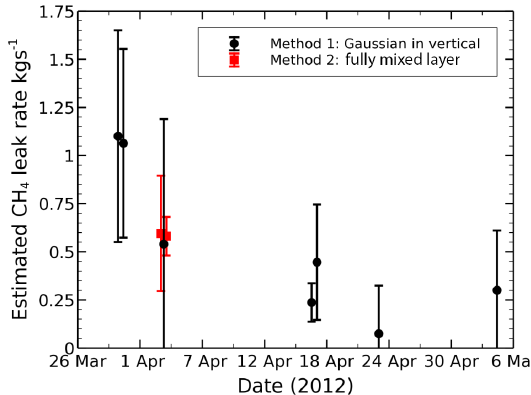
Figure 6. Methane flow rate from flights on 30 March, 3 April, 17 April, 24 April and 4 May 2012. The symbols in black show flow rates calculated using method 2 and those in red show flow rates calculated using method 1. Multiple results from the same flight are from different distances downwind from the Elgin rig and/or from different calculation methods. The time separation of multiple re- sults from the same flight have been slightly exaggerated for